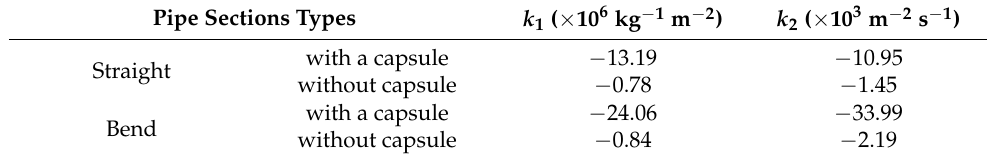
Figure 5. S imulated pressure drop characteristics of various pipe-section units: ( a ) straight-without capsule; ( b ) straight-with a capsule; ( c ) bend-without capsule; ( d ) bend-with a capsule. Table 2. Obtained values of k 1 and k 2 by 3D simulation and curve fitting.